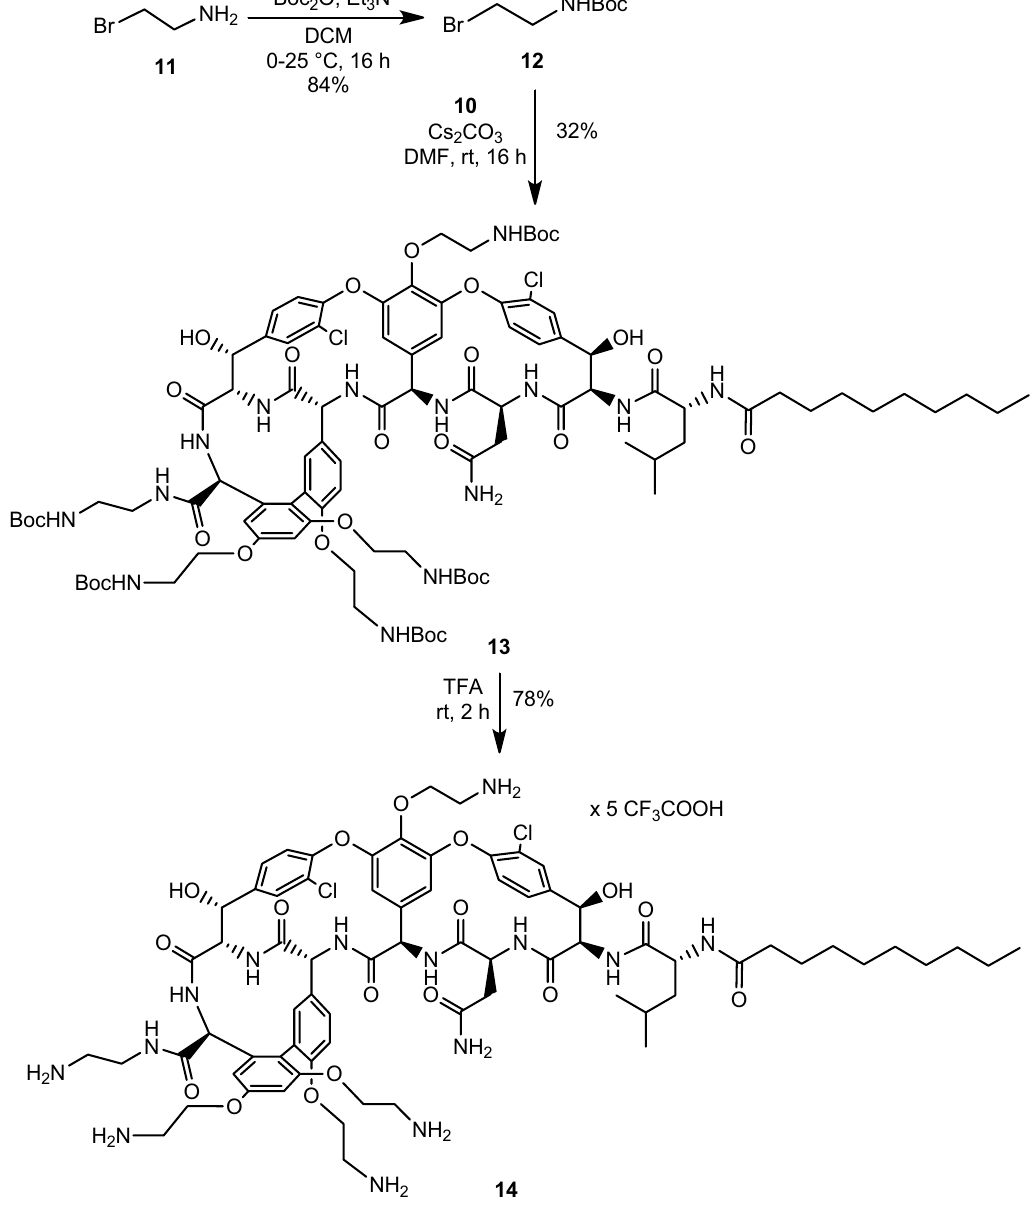
Figure 5. The alkylation of phenolic OH-groups and global